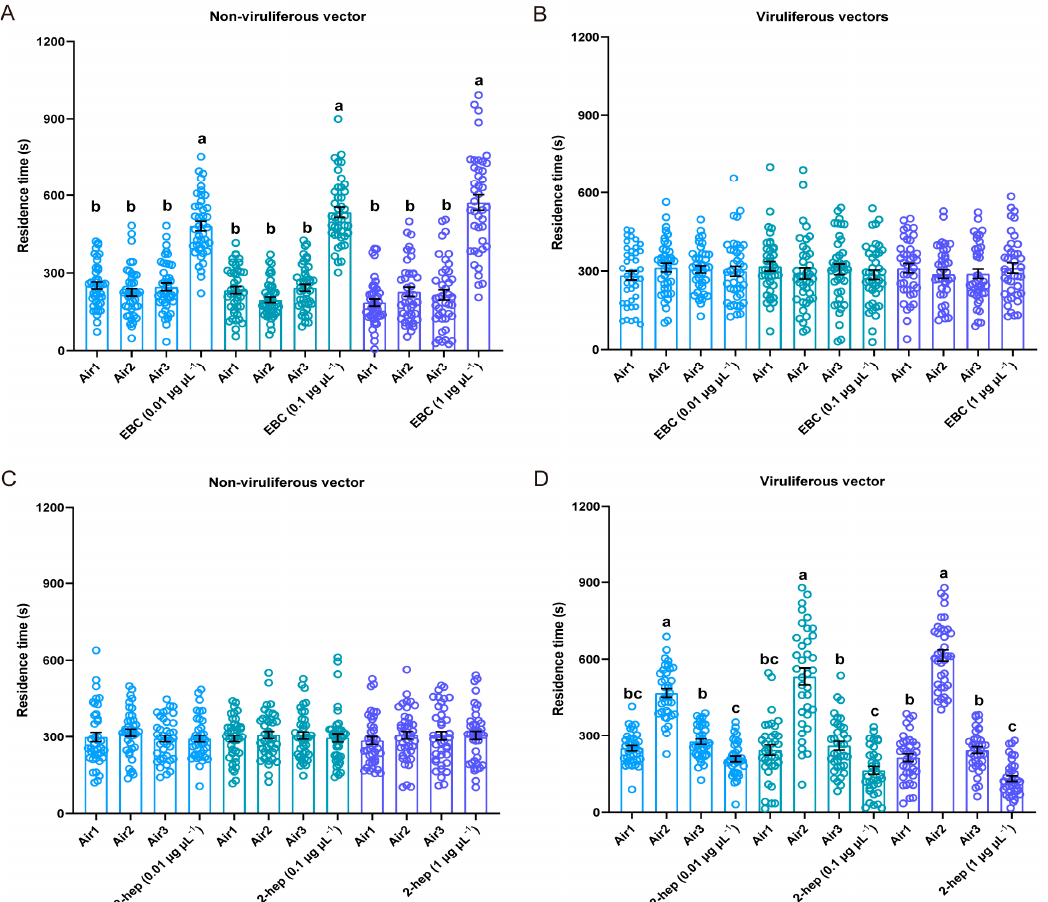
Figure 3 . Behavioral responses of N. virescens when exposed to individual VOCs. Residence time in the four-field olfactometer as in Figure 2. The effects of three doses of (E)- β -caryophyllene on non- viruliferous N. virescens ( A ) (0.01 μ g μ L − 1 , n = 42; 0.1 μ g μ L − 1 , n = 42; 1 μ g μ L − 1 , n = 42) and viruliferous N. virescens ( B ) (0.01 μ g μ L − 1 , n = 40; 0.1 μ g μ L − 1 , n = 40; 1 μ g μ L − 1 , n = 39). The effects of three doses of 2-heptanol on non-viruliferous N. virescens ( C ) (0.01 μ g μ L − 1 , n = 38; 0.1 μ g μ L − 1 , n = 40; 1 μ g μ L − 1 , n = 41) and viruliferous N. virescens ( D ) (0.01 μ g μ L − 1 , n = 36; 0.1 μ g μ L − 1 , n = 36; 1 μ g μ L − 1 , n = 37). EBC, (E)- β -caryophyllene odors; 2-heptanol, 2-heptanol odors; Air1, clean air; Air2, clean air; Air3, clean air. Deviations from equal distributions were analyzed with a Friedman–ANOVA ( p < 0.05). Bars annotated with different letters are significantly different from each other (Wilcoxon–Wilcox test). Data are mean ± standard error.